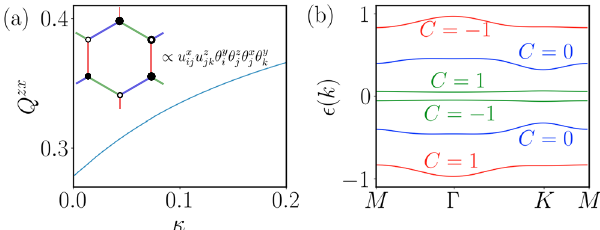
Fig. 4 Chiral KSL induced by [111] SIA. a Q zx as a function of κ . Inset: A sketch for the three-body quadrupolar interactions in Eq. (7). The blue, green, and red bonds stand for the x -, y -, and z -type S = 3/2 Ising interactions, respectively. The summation in Eq. (7) takes place over the triangle with vertexes i , j , and k (and symmetry-equivalent ones). b The band structure and corresponding Chern numbers for the parton MF theory in Eq. (8) with κ =